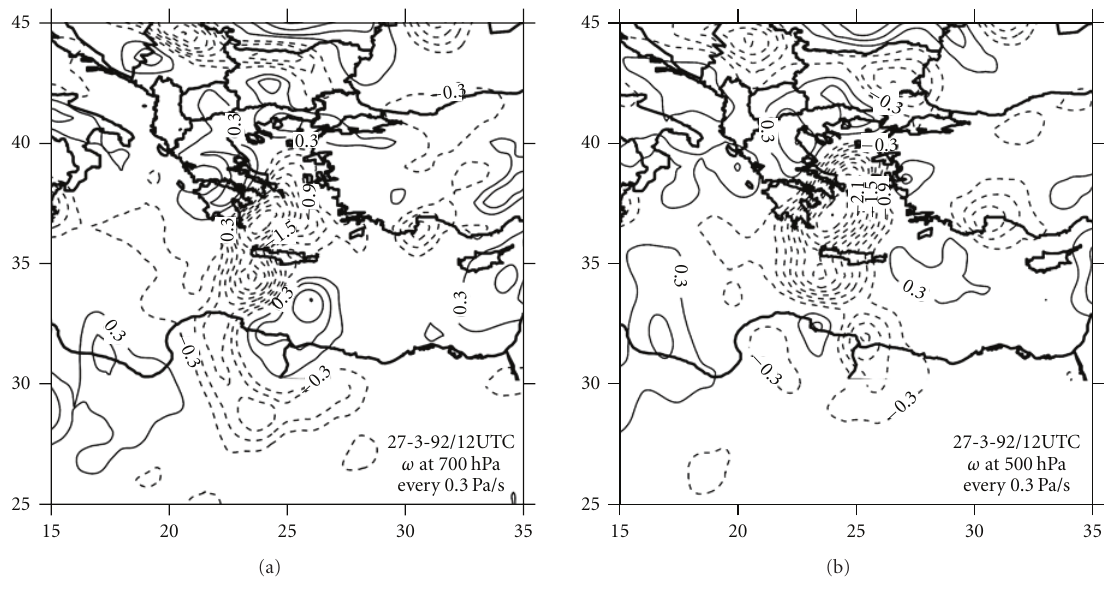
Figure 7: Same as Figure 2, but for (a) 700 hpa and (b) 500 hpa for 27 March 1992/12:00